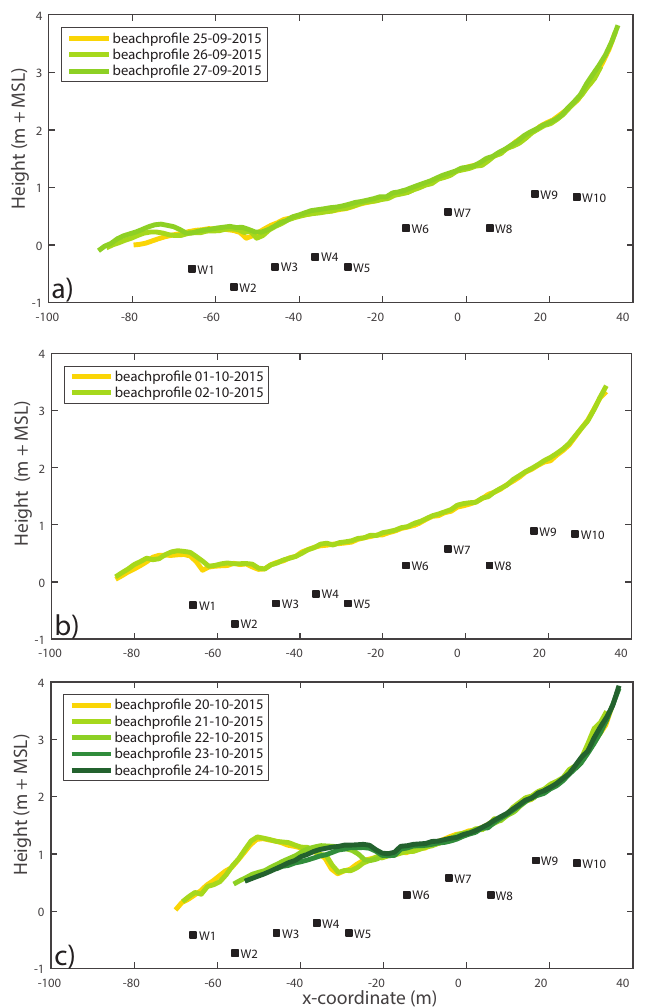
Figure 4. Side view of beach height profiles, taken on the same 10 days of Theta probe measurements, with the groundwater wells indicated by W1–W10. Note how the sandbars move over time from the sea towards the dunes ( a – c